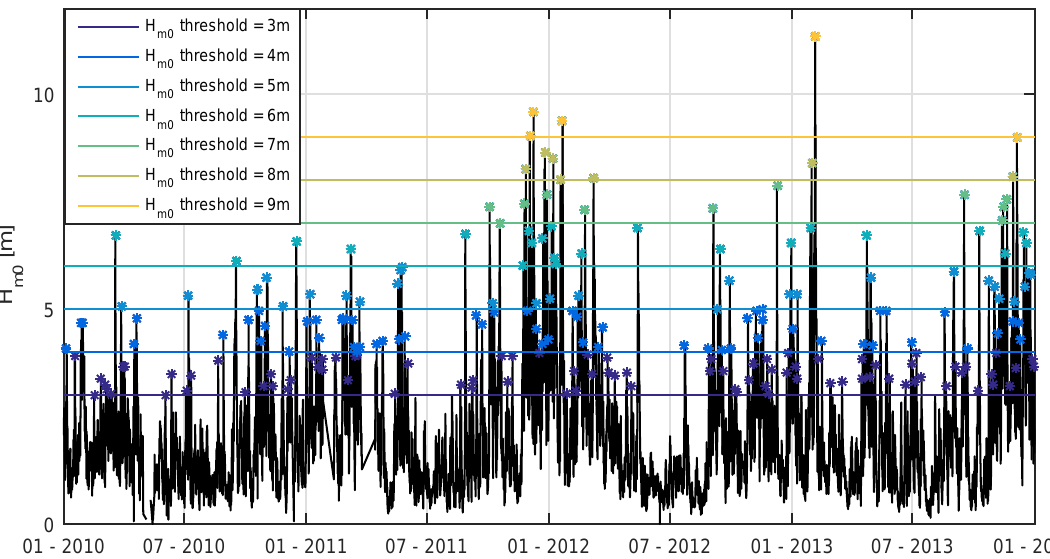
Figure 2. Demonstration of correct Peaks Over Threshold (POT) identification. To be considered a peak, each point over the threshold must be the maximum in the 24 h preceding and after the point of interest. Four years of data is shown, from 1 January 2010 to 31 December